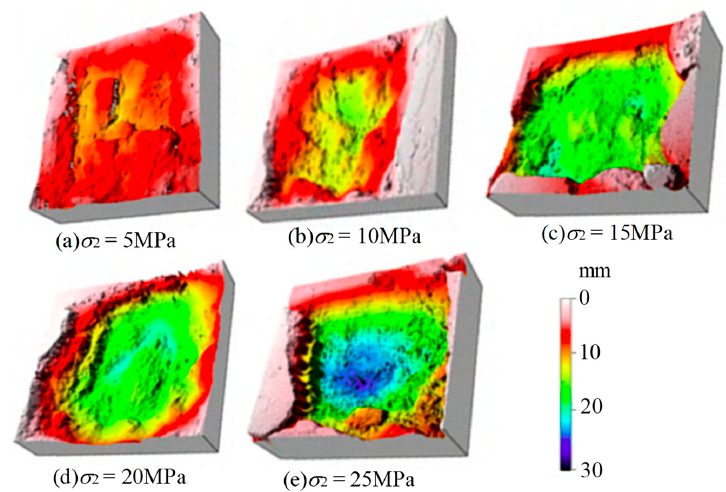
Figure 6. Variations of fractured surface with increase of major confining pressure ( σ 2 ), while minor confining pressure ( σ 1 ) is constant at 5 MPa.